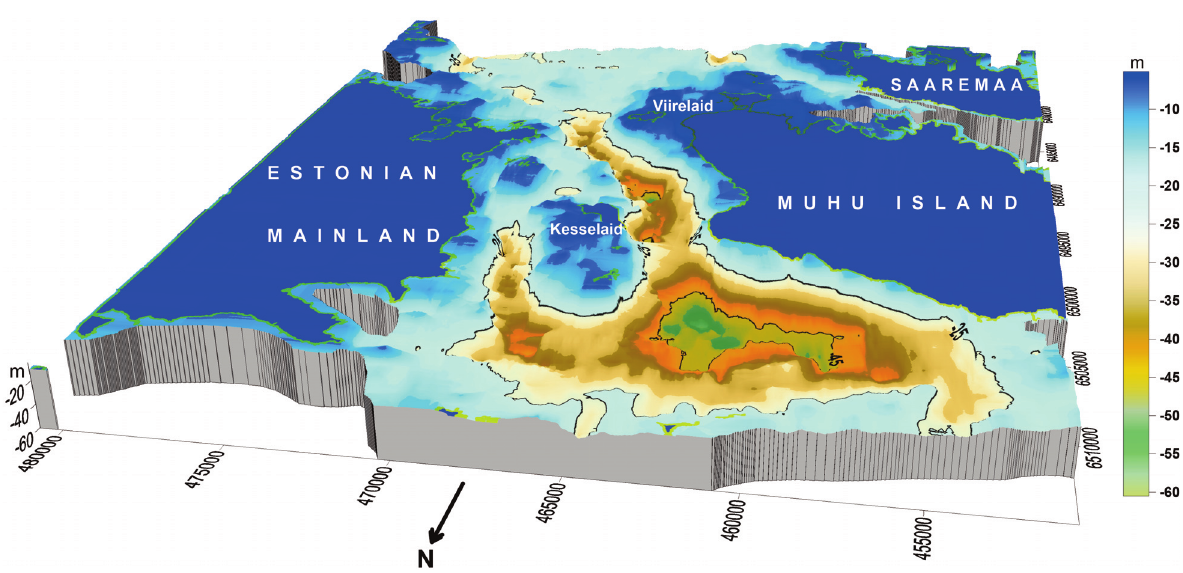
Fig. 5. Perspective look at our study area from the SSW (interior of the Väinameri) depicted on the bedrock relief model showing a depression NW of Kesselaid, channels in the Suur Strait divided by the Kesselaid elevation and a high-seated concave watershed plateau in the NE corner of the Gulf of